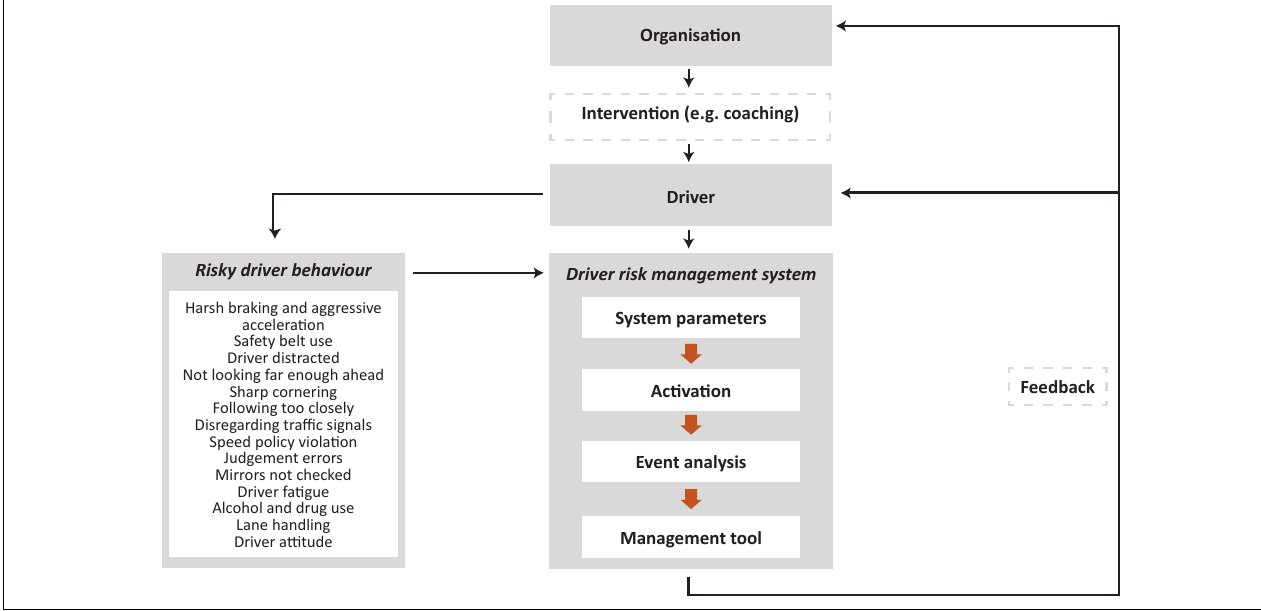
FIGURE 1: Framework for a driver risk management